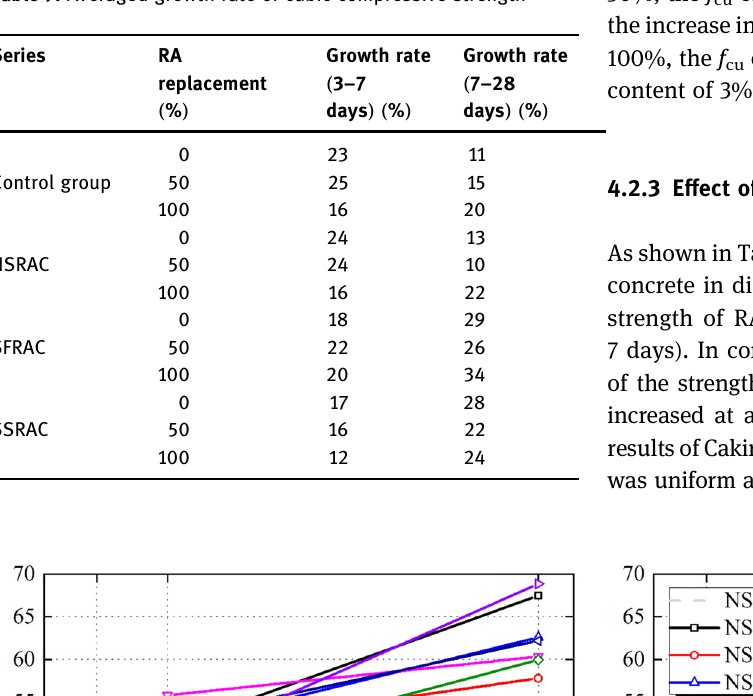
Table 7: Averaged growth rate of cubic compressive strength